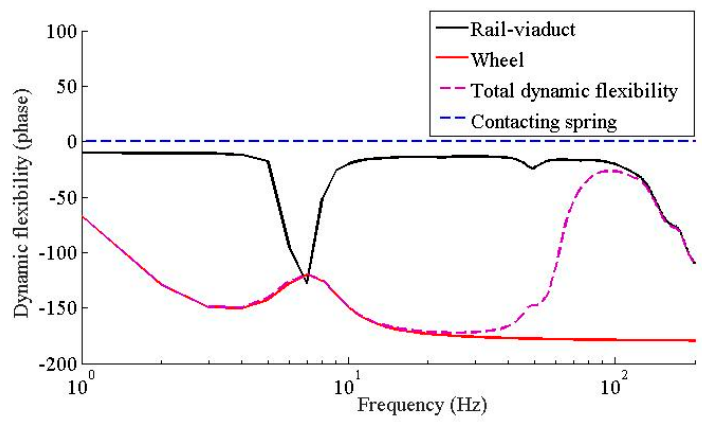
Figure 19. Phase of the dynamic flexibility of the vehicle-rail-viaduct system.